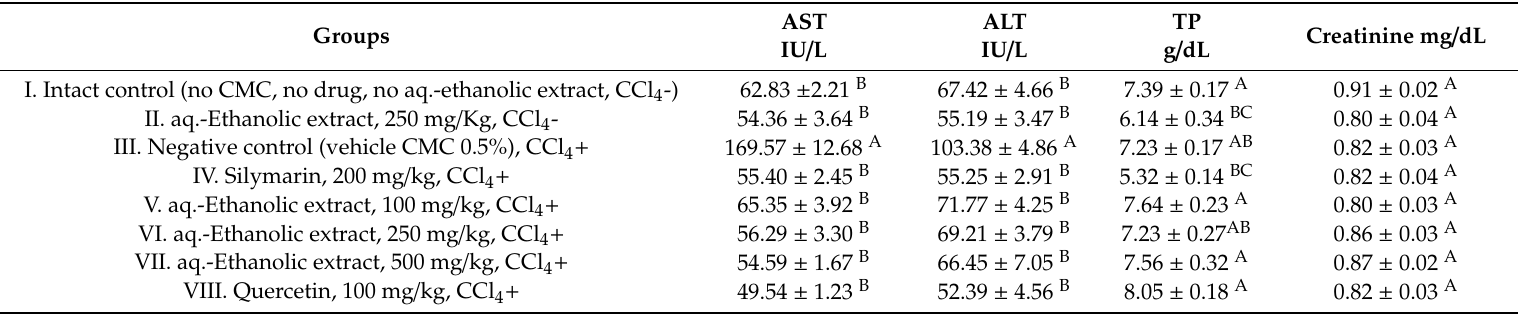
Table 3. E ff ect of aq.-ethanolic extract of Suaeda vermiculata on liver and kidney functions on carbon tetrachloride-induced liver toxicity in experimental rats.